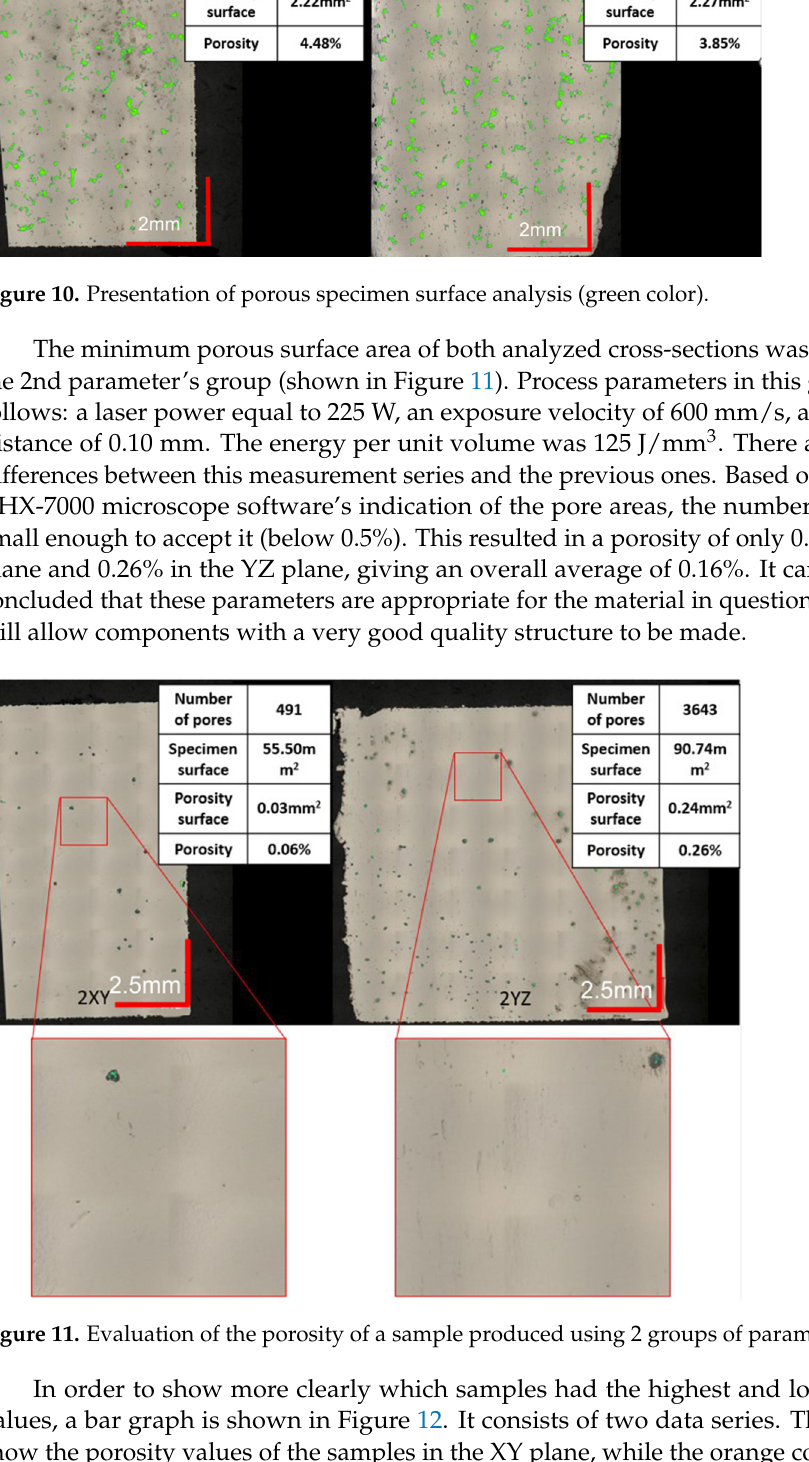
Figure 12. Columnar chart showing porosity in two planes of each tested parameter group. Based on an analysis of the specimen structure manufactured with different parameters, a group of those that provided the lowest porosity was selected. Their values are shown in Table 3.